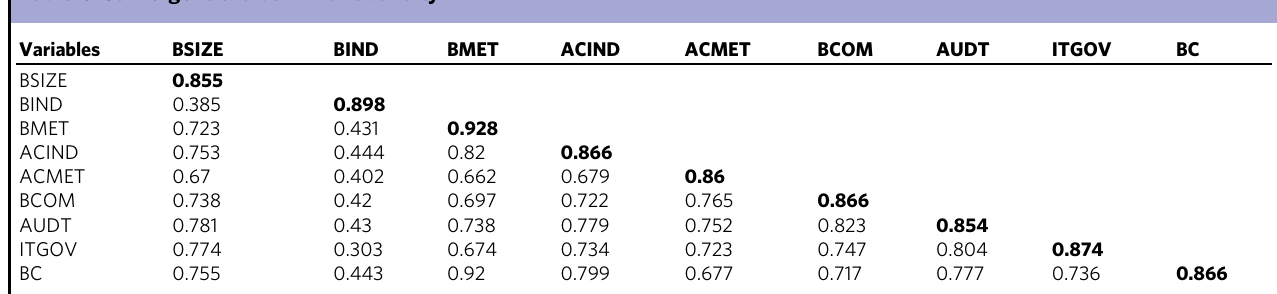
Table 6 Convergent & discriminant validity.